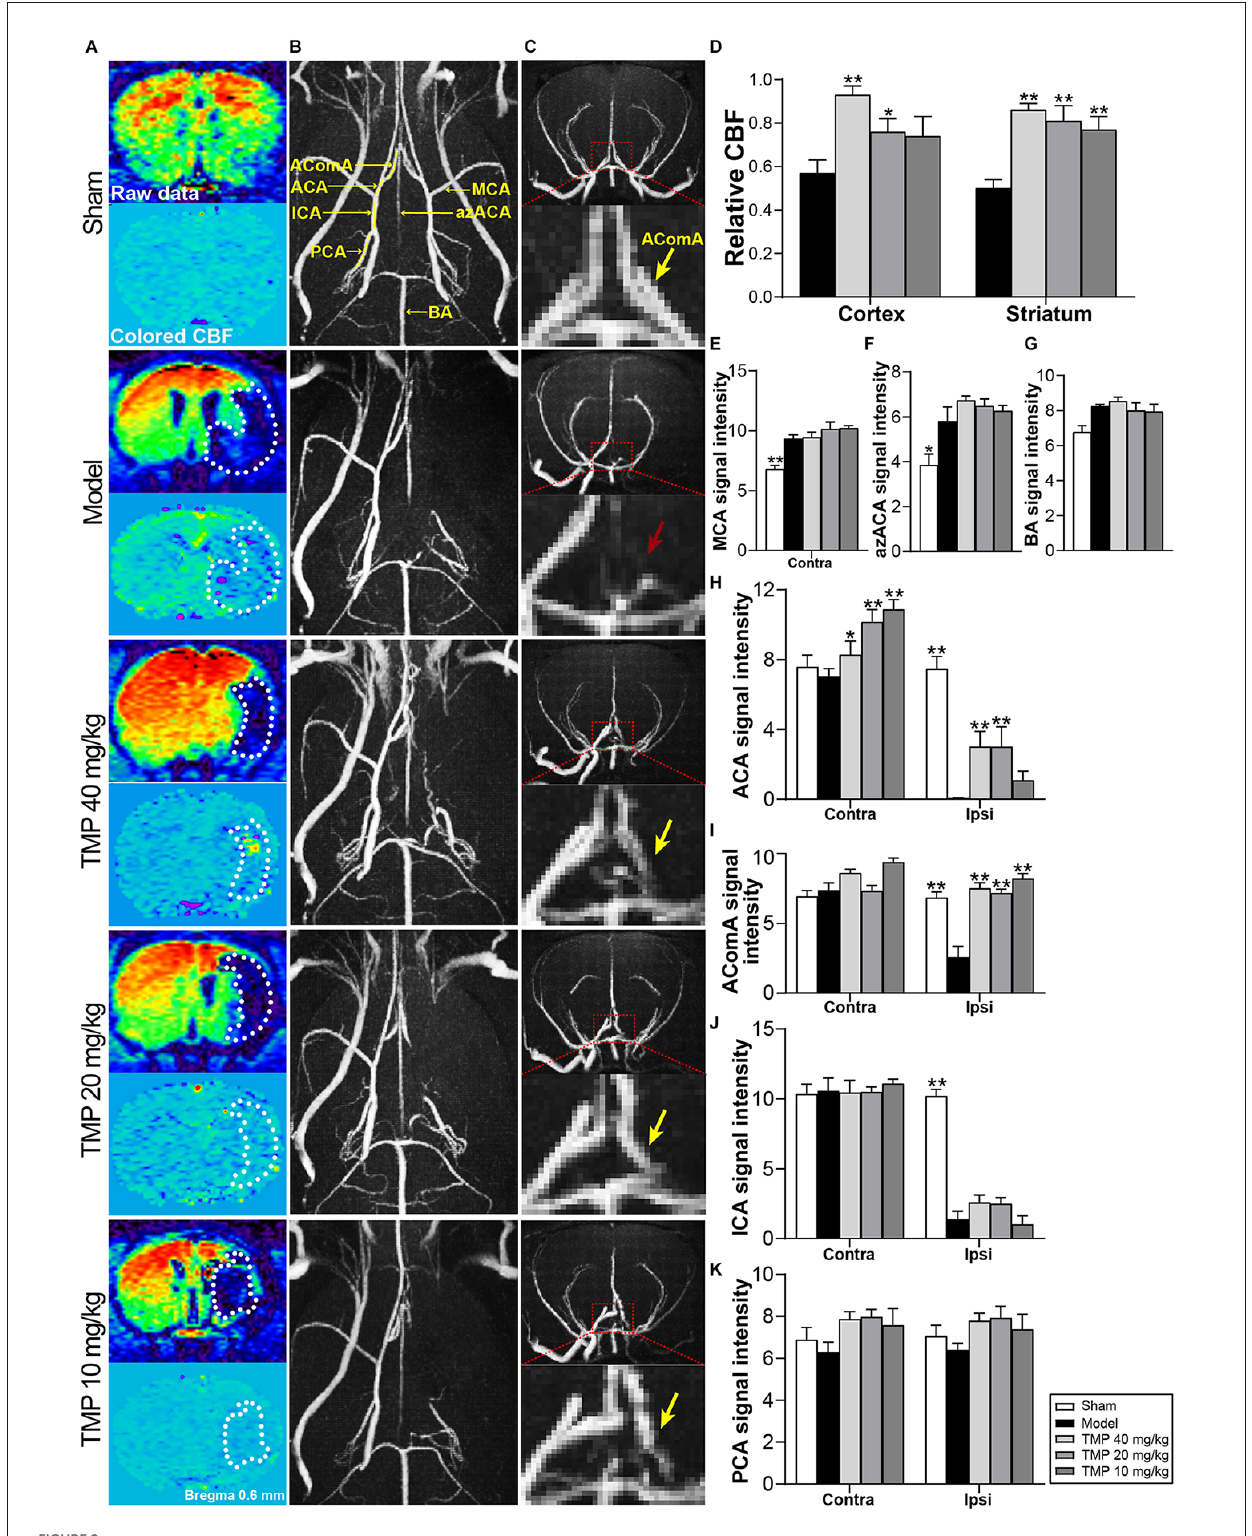
FIGURE2 TMP improved cerebral perfusion and enhanced vascular signals of MCAO rats. (A) ASL and colored CBF images showed cerebral perfusion ( n = 6). The infarctions were marked with white dotted lines. (B) Axial and (C) coronal MRA images showed cerebral vascular signals ( n = 6). Signals in ipsilateral MCA regions were obviously absent in the Model group. AComA areas were magnified in coronal images (red dotted boxes). The disappeared AComA signal (red arrow) was indicated in the Model group and it reappeared in TMP groups (yellow arrows). (D) Quantitative analysis of rCBF in the periinfarct cortex and striatum, and signal intensity of (E) MCA, (F) azACA, (G) BA, (H) ACA, (I) AComA, (J) ICA, and (K) PCA. Abbreviations: MCA,middlecerebralartery;ACA,anteriorcerebralartery;AComA,anteriorcommunicatingartery;ICA,internalcarotidartery;PCA,posteriorcerebral artery; azACA, anterior azygos cerebral artery; BA, basilar artery; Contra, contralateral; Ipsi, ipsilateral. * P < 0.05, ** P < 0.01 vs. Model